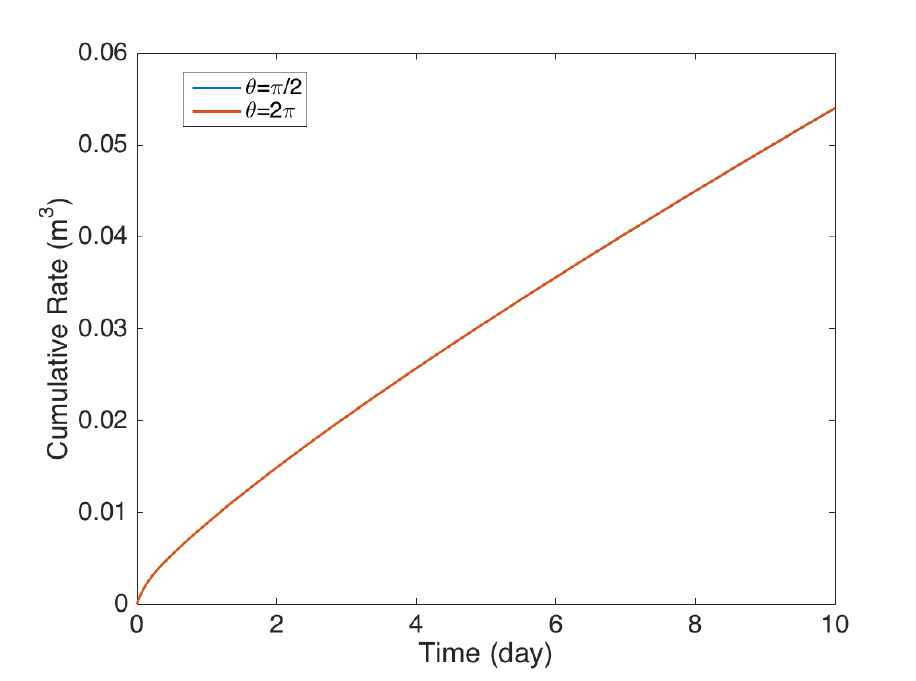
Figure 12. The cumulative production for various values of the parameter θ .